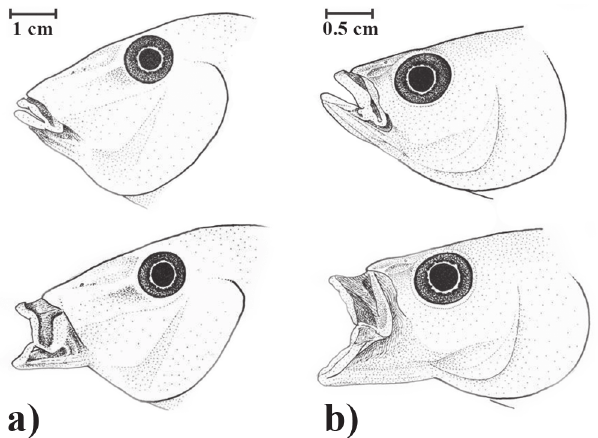
Fig. 2. Head of Satanoperca pappaterra (a) and Crenicichla britskii (b) , showing differences in the mouth